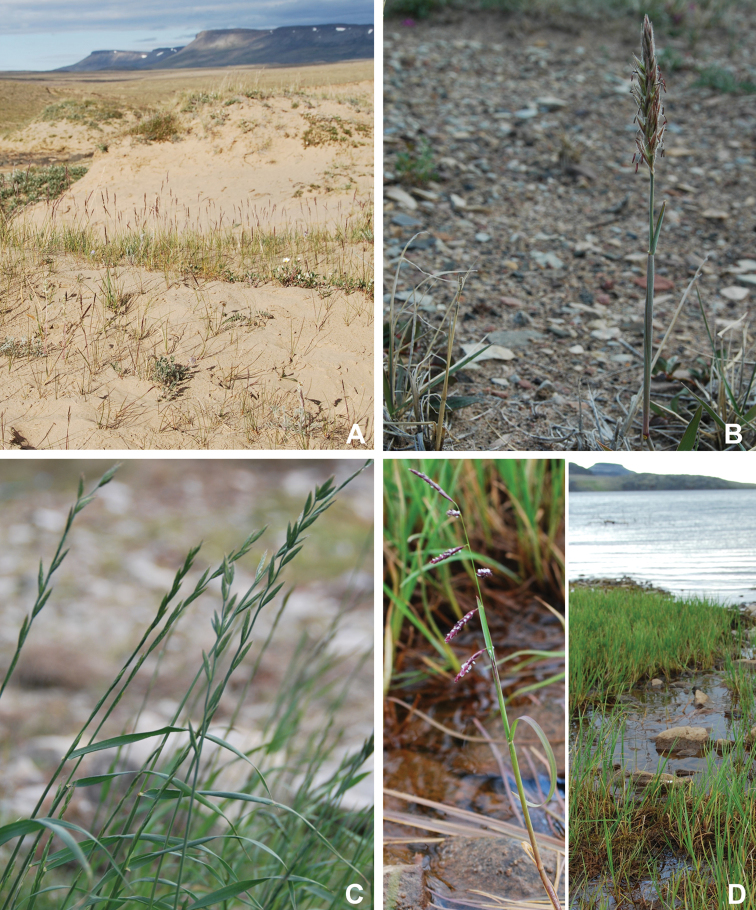
AFestuca
rubra
subsp.
arctica habitat, Gillespie et al. 9913BLeymus
mollis
subsp.
villosissimus habit, Gillespie et al. 8098CLolium
perenne habit, Saarela & Teeter 9674DPleuropogon
sabinei habit (left) and habitat (right), Gillespie et al. 9865. Photos A, C, D by J.M. Saarela and B by R.D. Bull.